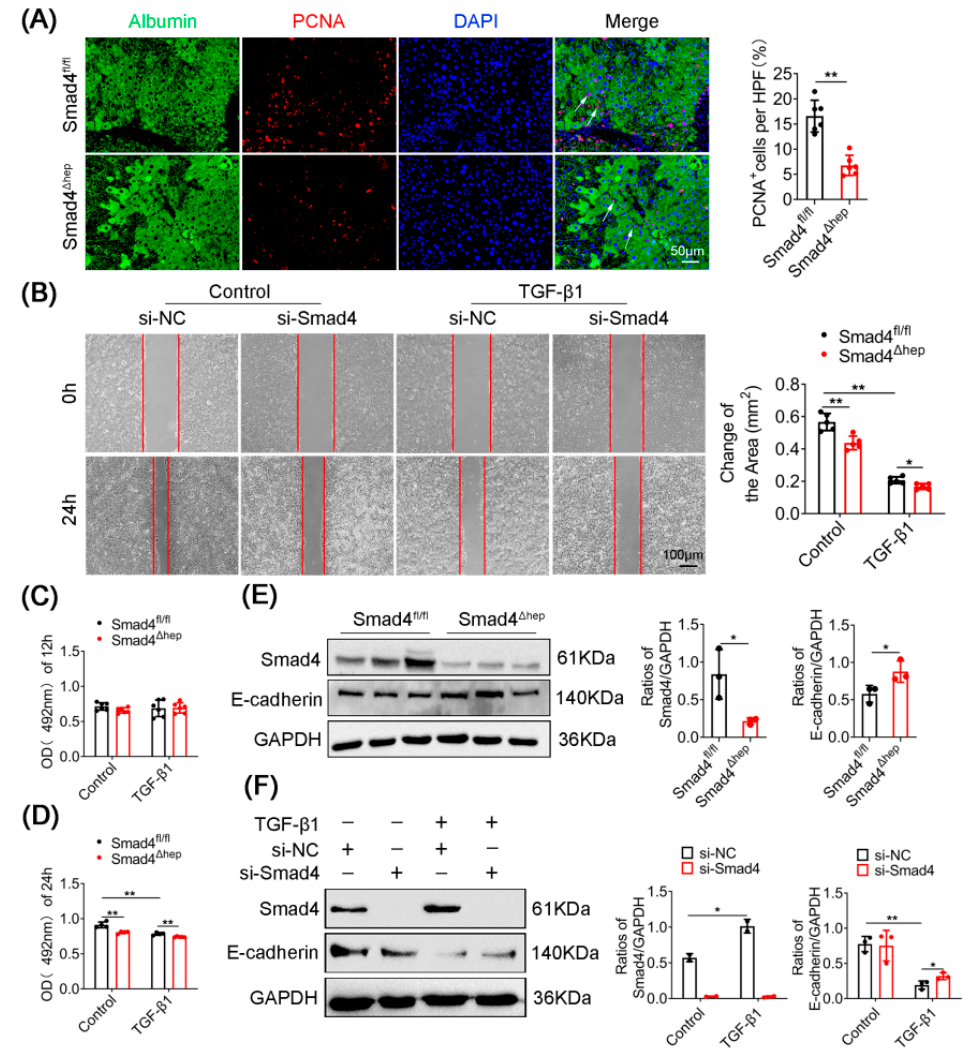
Figure 3. Hepatocyte-specific Smad4 deficiency reduces cell proliferation and EMT. Smad4 fl/fl and Smad4 ∆ hep mice were treated with CCl 4 for 4 weeks to establish a liver fibrosis model. AML-12 cells were transfected with control siRNA or Smad4 siRNA. ( A ) Double staining of Albumin (green) and PCNA (red) in fibrotic liver tissues (scale bars: 50 µ m) and statistical analysis. Arrowheads indicated the double-positive cells. ( B ) Representative photographs of wound-healing assay and statistical analysis. AML-12 cells were scratched using pipet tips and treated with TGF- β 1 (5 ng/mL) for 24 h. The migration ability of AML-12 cells was evaluated. ( C , D ) AML-12 cells after Smad4 deletion were treated with TGF- β 1 (5 ng/mL) for 12 h or 24 h. The MTT assays showed that the proliferation ability of AML-12 cells. ( E ) Smad4 and E-cadherin expression in fibrotic liver tissues of CCl 4 -treated Smad4 ∆ hep mice were analyzed by Western blotting. Smad4 and E-cadherin were normalized to GAPDH. ( F ) Smad4 in AML-12 cells were knocked down by siRNA and then treated with TGF- β 1 (5 ng/mL) for 24 h; Smad4 and E-cadherin expressions were analyzed by Western blotting and normalized to GAPDH. * p < 0.05, ** p <